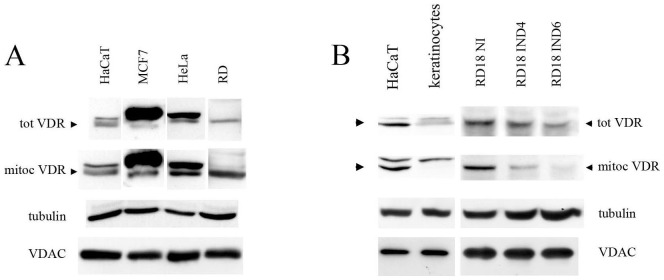
Proliferating human cells express mitochondrial VDR, whereas differentiated cells display reduced levels of receptor expression.(A) VDR expression was analyzed in a panel of several human cell lines using western blotting in total lysates (tot VDR) and mitochondrial extracts (mitoc VDR). For RD and MCF7 cells, VDR detection required a longer duration of exposure to ECL. (B) Two models of cellular differentiation were used to assess VDR levels in the total lysates and mitochondrial fractions: Human proliferating HaCaT cells vs. human primary differentiated keratinocytes and differentiation-inducible RD18 cells carrying a doxycycline-inducible miR-206-expressing lentiviral vector in the absence (uninduced: NI) or presence of doxycycline for four (induced: IND4) and six days (induced: IND6). Tubulin detected in total extracts and VDAC levels in mitochondrial fractions were used as internal controls for protein loading. The blots are representative of a set of three independent experiments.